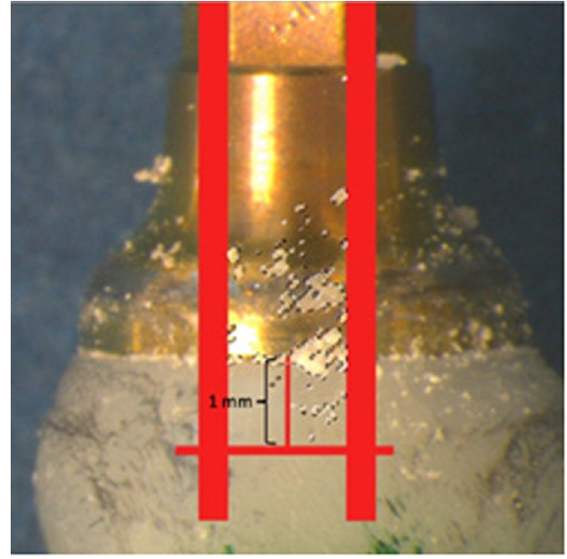
Fig. 7 Measurement tool. Highlighted pixels of cement excess within the measurement tool (red).